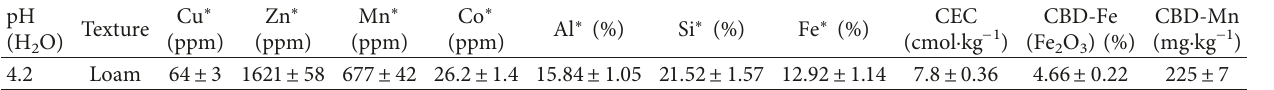
Table 1: The basic physicochemical properties of the tea garden lateritic soil used in this